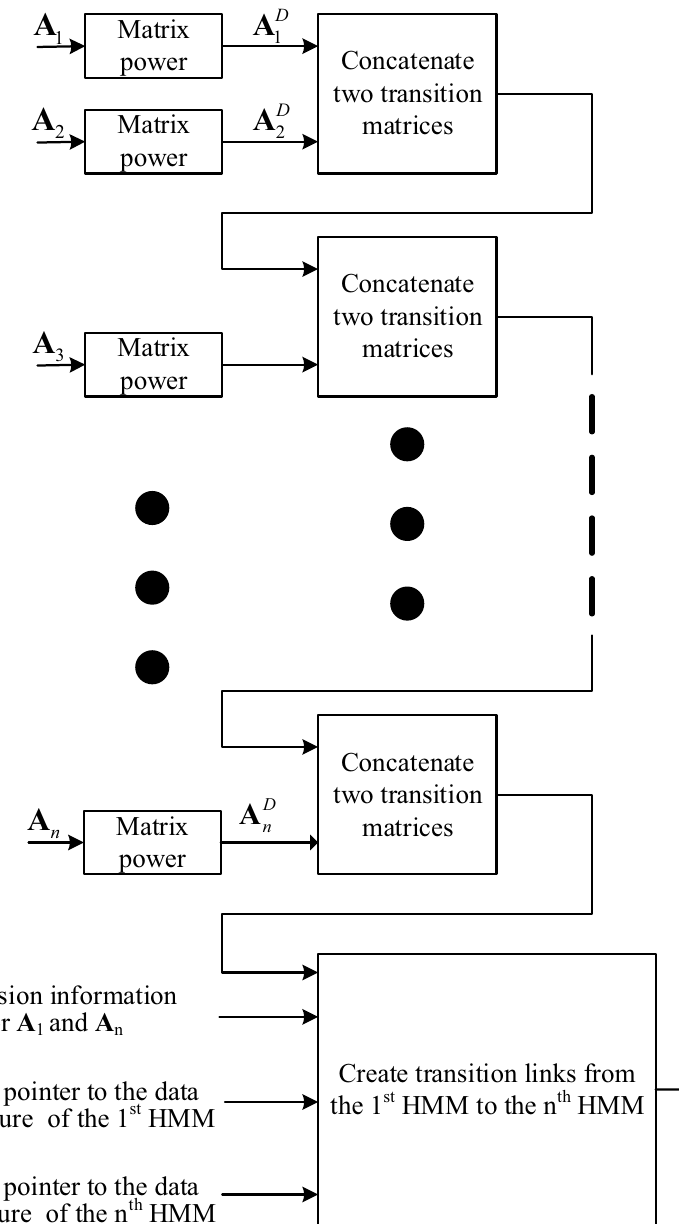
Fig 8. The creation of transition links from the 1 st HMM to the n th HMM for frame rate reduction factor D using the adapting-then- connecting approach.